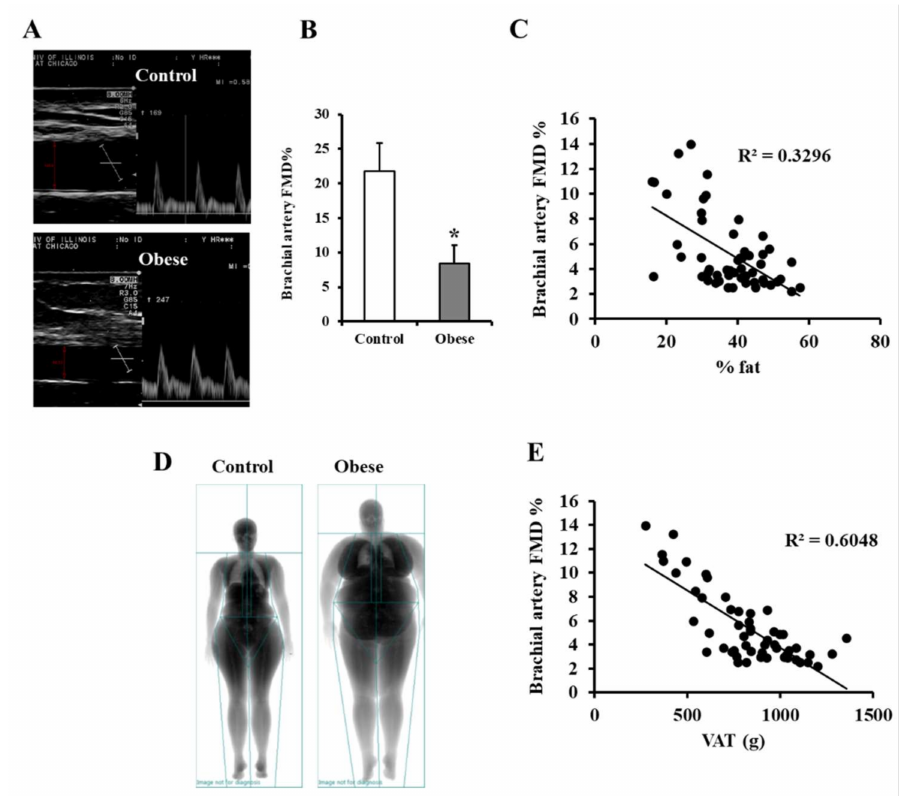
Figure 7. FMD measurements in the brachial artery. ( A ) Duplex B-mode/PWD (pulsed wave Doppler) ultrasound of brachial artery FMD showing a long axis scan of the artery and a pulsed wave Doppler blood velocity profile. ( B ) By subtracting the average baseline diameter from the largest mean values obtained following cuff deflation, the percentage of brachial artery FMD was estimated in obese subjects ( n = 60) and non-obese controls ( n = 60). ( C ) A scatter plot and Spearman correlation coefficient (r) of FMD and total fat % measured via DEXA scanning. ( D ) Representative images of total body composition measurements by dual-energy X-ray absorptiometry (DEXA) scanning in obese and control subjects. ( E ) A scatter plot and Spearman correlation coefficient (r) of FMD and total VAT % measured via DEXA scanning. Results are presented as means ± SE, and the * symbol reflects a p -value < 0.05 when comparing obese subjects with